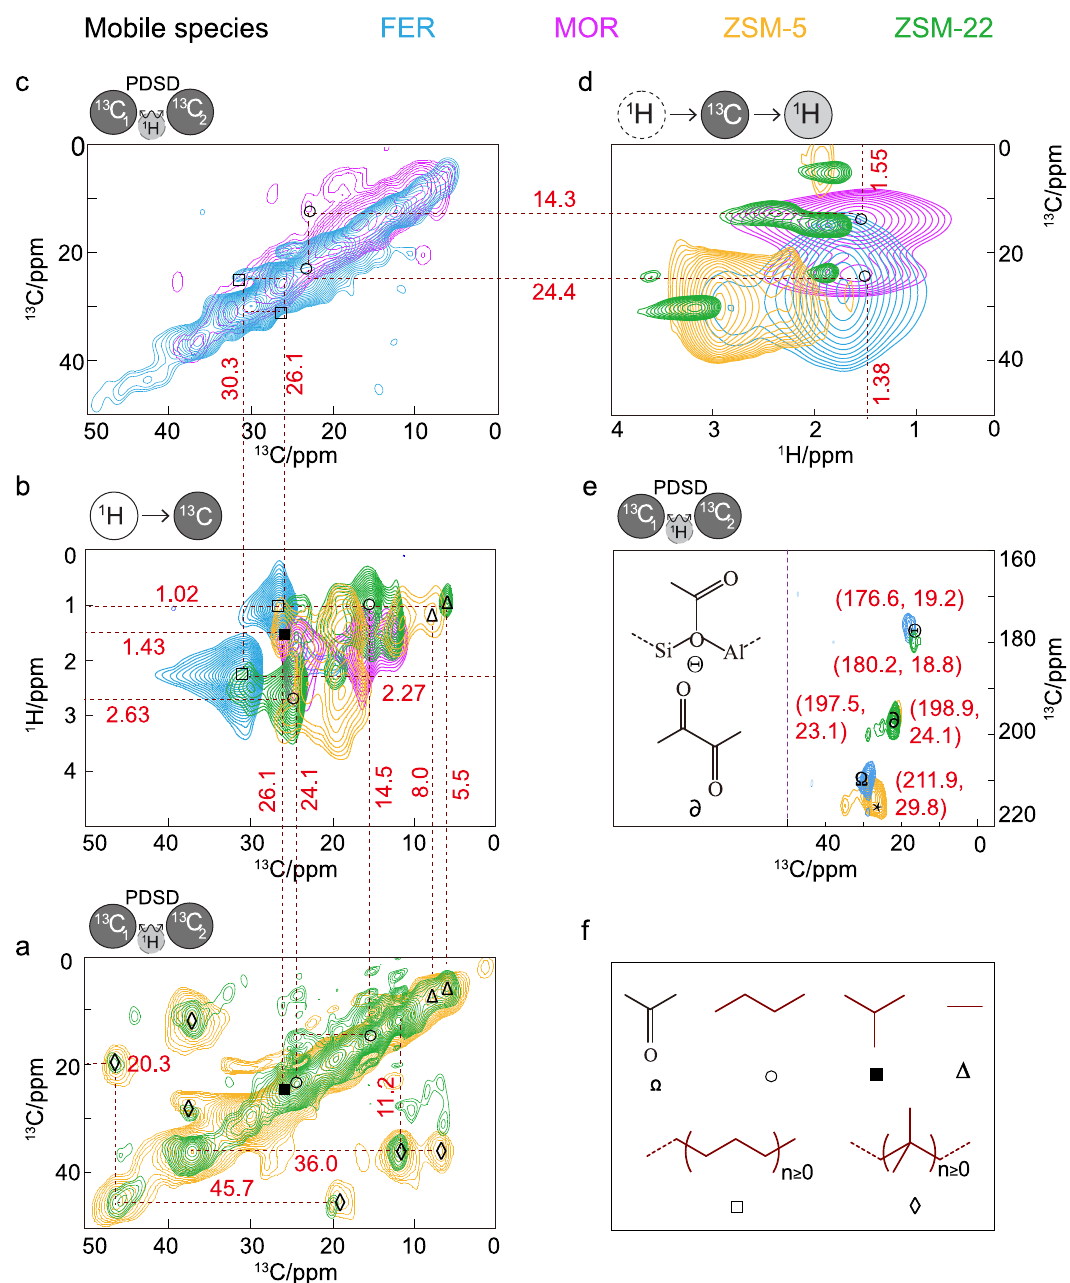
Fig. 4 Identi fi cation of postreacted zeolite-trapped mobile molecules by 2D MAS solid-state NMR spectroscopy. 13 C- 13 C correlations in the aliphatic regions on postreacted zeolites a ZSM-5 and ZSM-22 as well as c MOR and FER. b 1 H- 13 C INEPT HETCOR and d 13 C- 1 H HSQC spectra of the aliphatic region from all four postreacted zeolites. e 13 C- 13 C correlations in the carbonyl regions on postreacted zeolites FER, ZSM-5, and ZSM-22, highlighting the presence of ester and ketones (*: spinning sidebands on ZSM-5). See Supplementary Fig. 12 for the ssNMR spectra of these chemisorbed carbonylated species to verify the respective assignments. f Identi fi ed molecular scaffolds. To probe mobile 13 C- 1 H correlations, “ through-bond ” scalar magnetization transfer was used to polarize the carbons (in b and d ), whereas in the 13 C- 13 C correlation spectra, the carbons were polarized through direct excitation, and 13 C- 13 C mixing was achieved through proton-driven spin diffusion (PDSD) (in a , c , and e ). Spectra of trapped products obtained on respective postreacted zeolites after the hydrogenation of fully isotope-enriched 13 CO 2 in the reactant feed ( 13 CO 2 at 30 bar, 375 °C, H 2 / 13 CO 2 = 3, and 10,000mL · g − 1 · h − 1 at a time on stream of 48 h). The respective full-range spectra, as well as experimental details, are included in Supplementary Information (MAS magic angle spinning, HETCOR HETeronuclear CORrelation spectroscopy, INEPT insensitive nuclei enhanced by polarization transfer, HSQC heteronuclear single quantum coherence